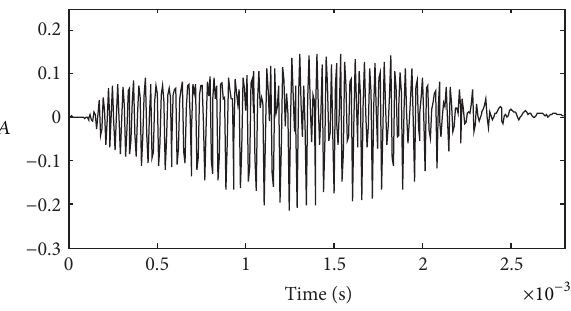
Figure 18: Eptesicus fuscus bat echolocation